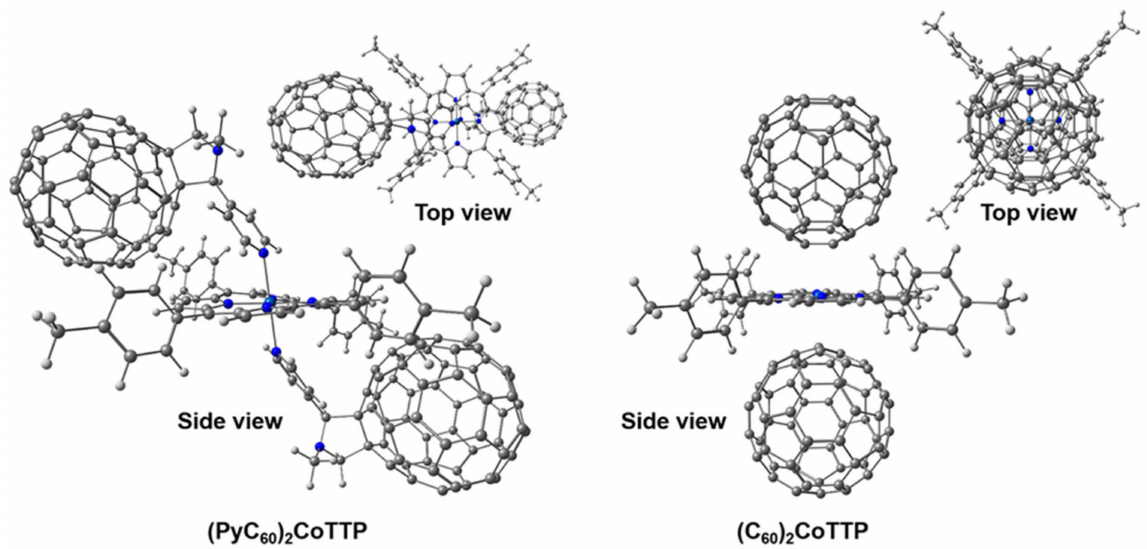
Figure 10. The optimized structures of (PyC 60 ) 2 CoTTP ( left ) and (C 60 ) 2 CoTTP ( right